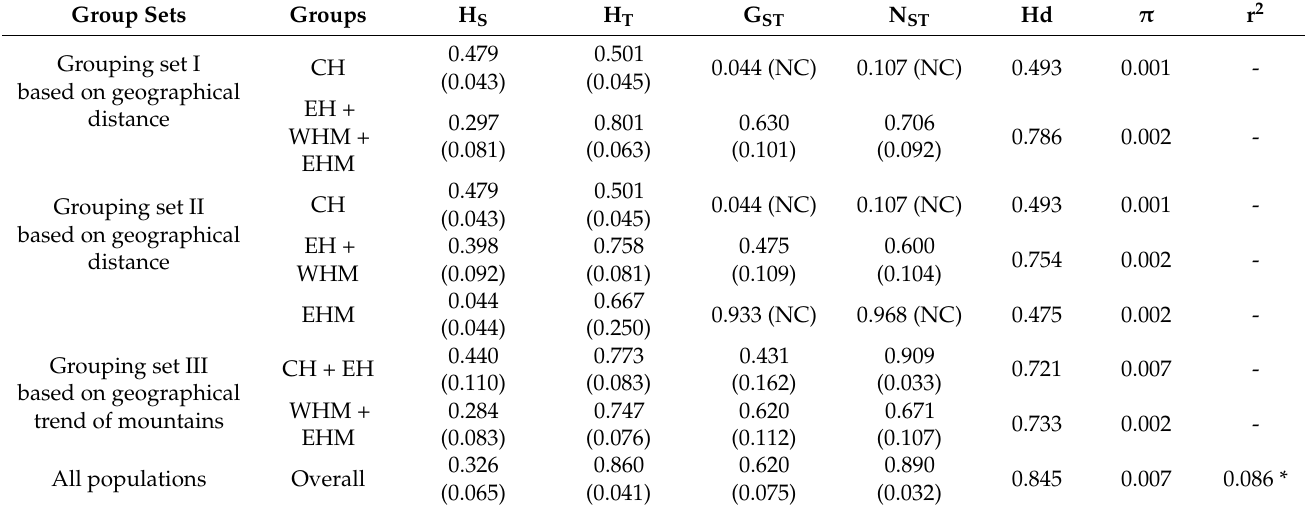
Table 1. Genetic diversity indices and genetic differentiation values of groups and overall (all populations) in Gaultheria nummularioides . Populations were divided into six basic groups in three ways, based on geographical distance and the trend of mountains: CH from the central Himalaya, EH + WHM + EHM from the eastern Himalaya plus the Hengduan Mountains, CH + EH from the Himalaya, WHM + EHM from the Hengduan Mountains, EH + WHM from the eastern Himalaya plus the western Hengduan Mountains, and EHM from the eastern Hengduan Mountains. Standard errors are shown in parentheses; HS represents average within-population genetic diversity and HT represents total genetic diversity; genetic differentiation coefficients between populations are represented by G ST and N ST and haplotype diversity (Hd) and nucleotide diversity ( π ) of groups in G. nummularioides are also presented. NC = not significant; r 2 = Mantel correlation coefficient, * p < 0.05; “-” = no